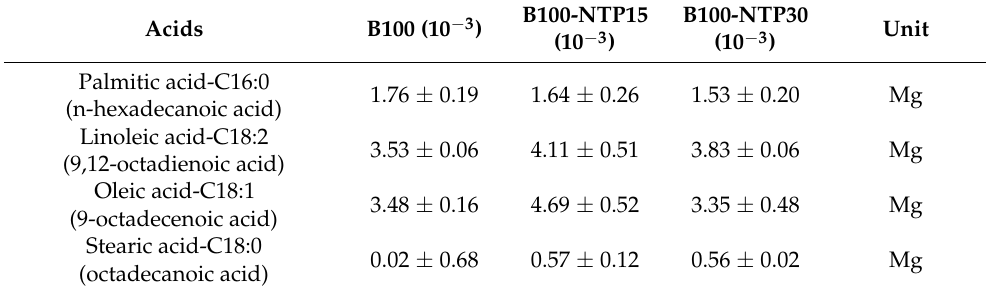
Table 3. Properties of biodiesel samples-indices of methyl/ethyl esters of fatty acids.